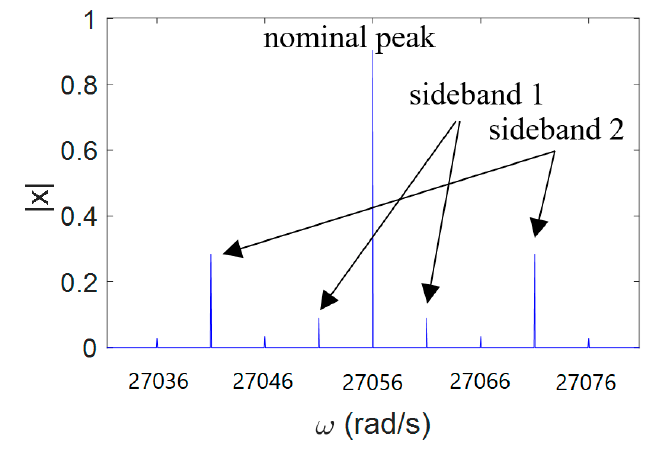
Figure 5. DFT of signal x = sin ( 27056 t − 0.2cos ( 5 t ) − 0.6cos ( 15 t )) . A nominal peak and two pairs of sidebands can be seen at ω = 27056 ± 5 and ω = 27056 ± 15 .